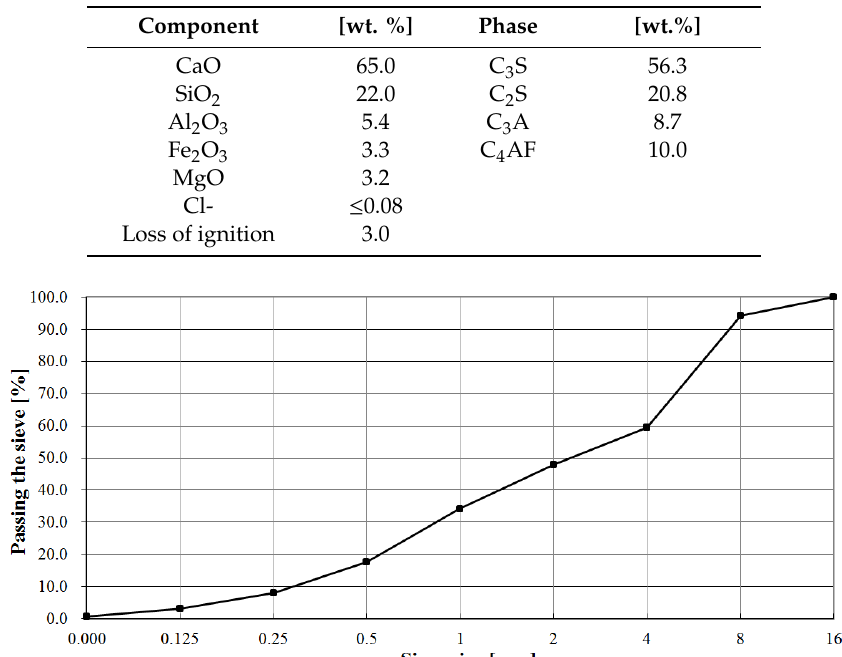
Table 1. Chemical and phase composition of Portland cement CEM I 52.5R.